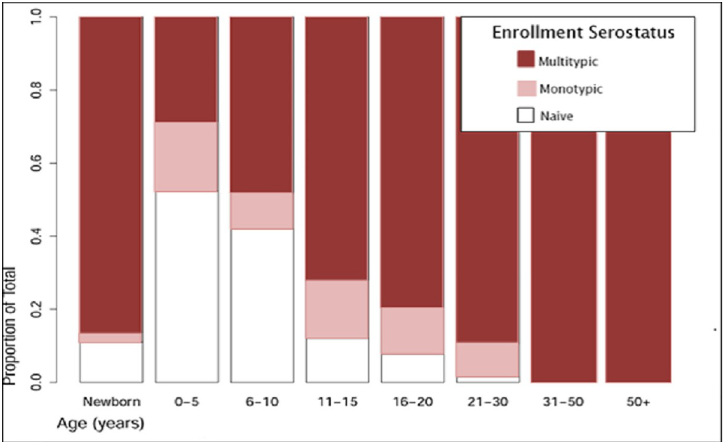
Fig 2. Dengue serostatus on enrollment in each age group, as determined by hemagglutination inhibition (HAI) assay. Graph show: DENV-na ï ve indicates HAI titers of � 10 for all four DENV serotypes (white), ‘monotypic’ indicates an HAI titer of > 10 for a single DENV serotype (pink), and ‘multitypic’ indicates HAI titers of > 10 for two or more serotypes